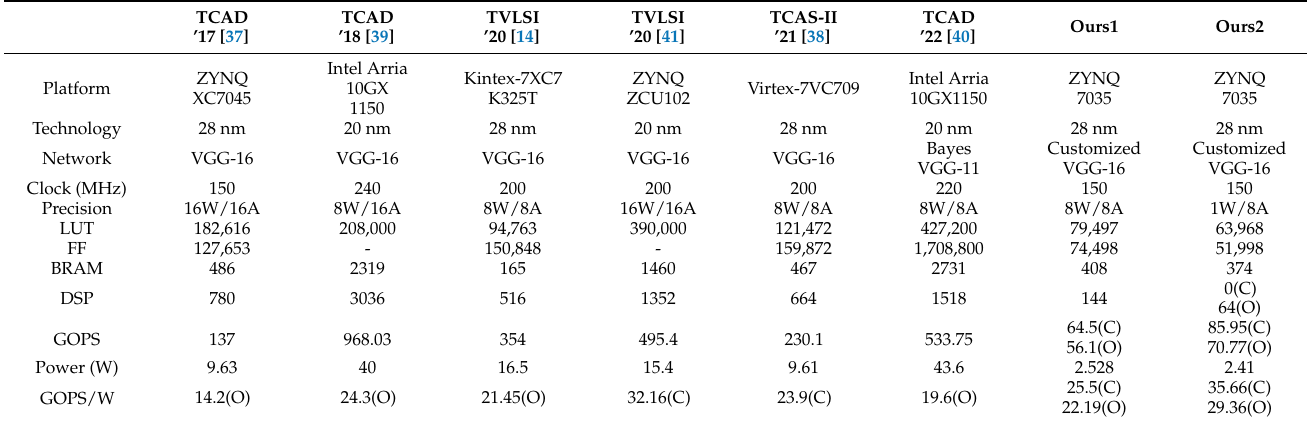
Table 8. Comparison with other implementations for VGG